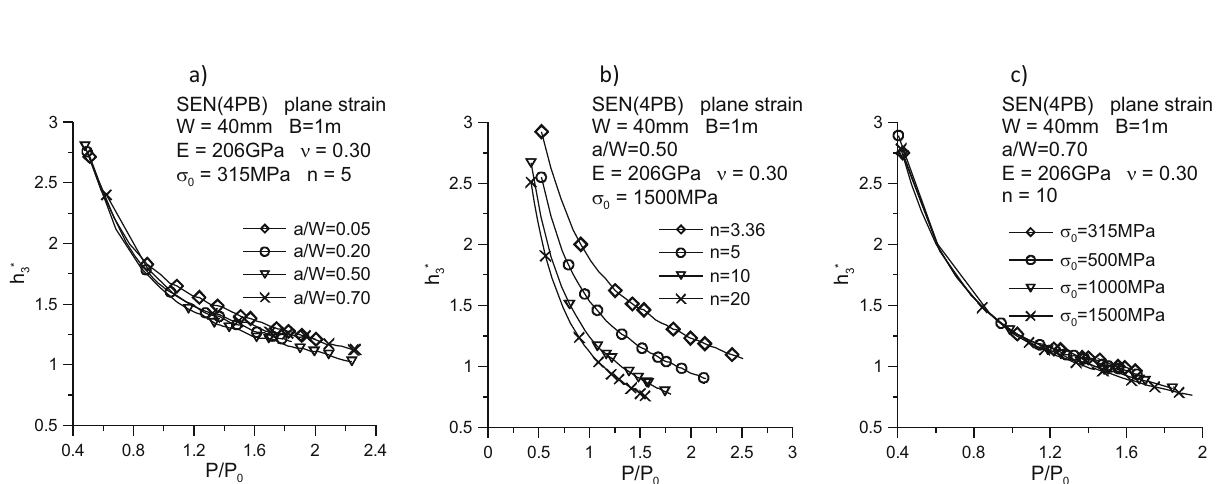
Figure 9: In fl uence of the relative crack length a / W ( a ) , the strain hardening exponent n in the R – O law ( b ) , and the yield point σ 0 ( c ) on the value of the h 3⁎ function for the entire external load spectrum.